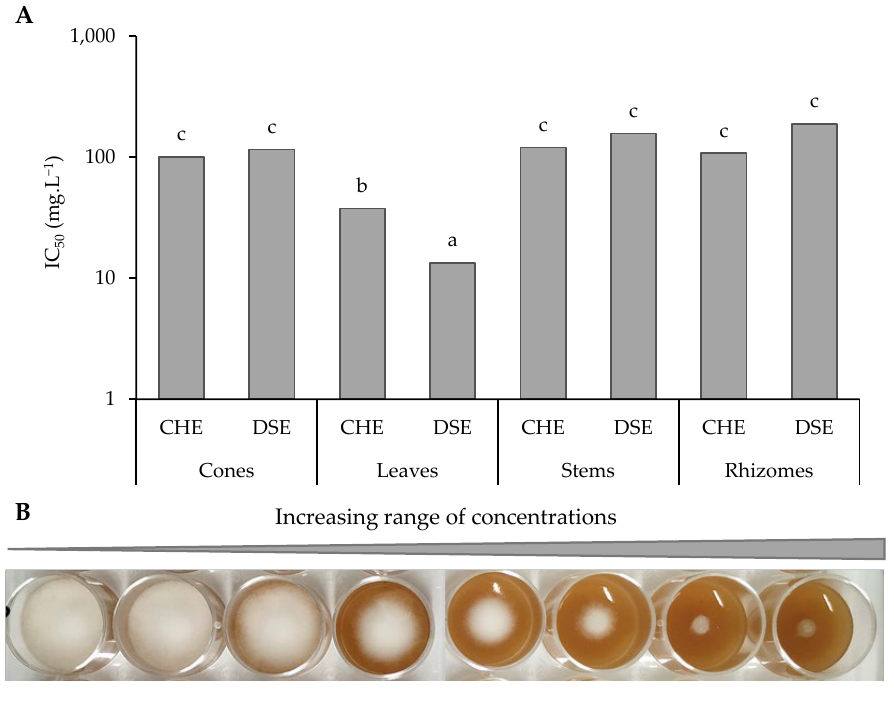
Figure 3. Anti-oomycete activity of hop extracts and sub-extracts on P. infestans mycelial growth. ( A ) Half maximal inhibitory concentration (IC 50 ) values. ( B ) Inhibition of mycelium growth on V8 medium by a range of concentrations (0 to 250 mg.L − 1 ) of DSE of leaves after 10 days. Different letters represent significant differences.